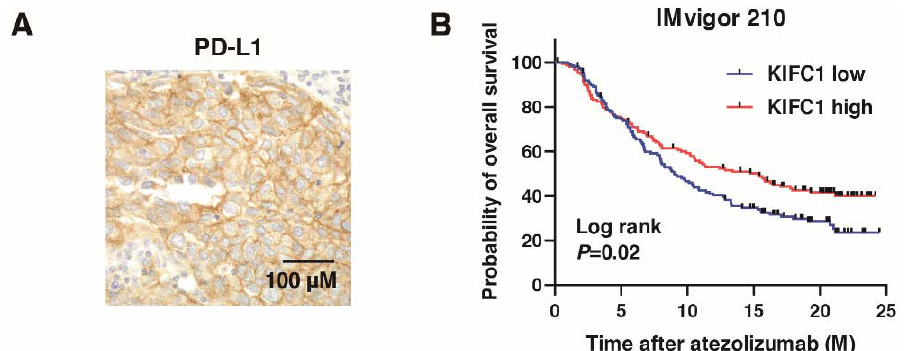
Figure 8. KIFC1 expression is associated with PD-L1 expression and favorable prognosis after PD-L1 inhibition in bladder cancer (BC). ( A ) Representative immunohistochemical images of KIFC1 and PD-L1 expression in BC. Original magnification: 400 × . ( B ) Kaplan-Meier plot of survival of BC patients treated with atezolizumab according to KIFC1 expression in the IMvigor 210 study.